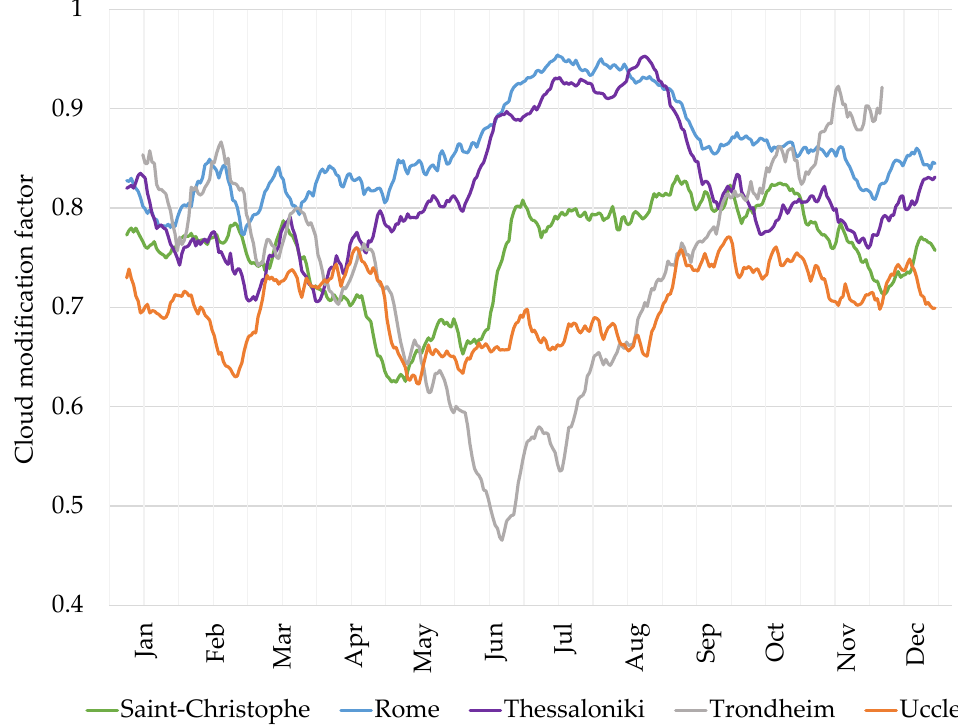
Figure 11. Mean cloud modification factors from the noontime satellite-based UVI climatology in Saint-Christophe, Rome, Thessaloniki, Trondheim and Uccle during the time period 2005–2015, shown as smoothed averages for a ±7 days